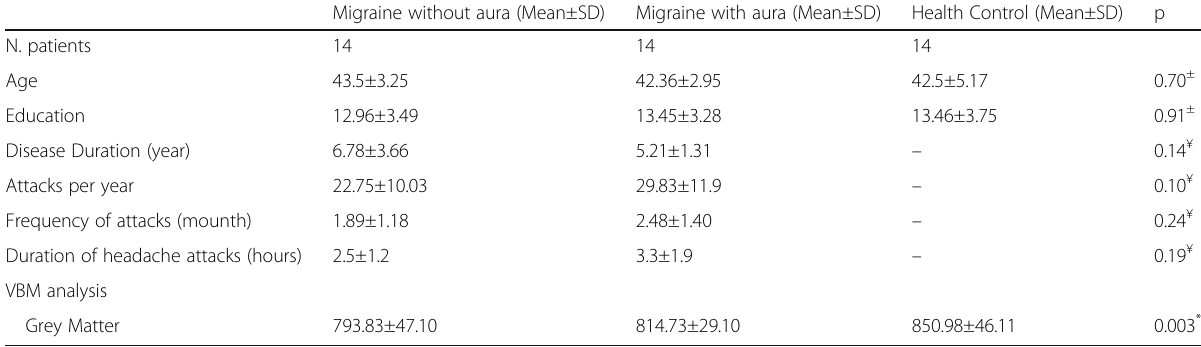
Table 1 Socio-demographic and clinical characteristics of three groups (% frequency) Migraine without aura (Mean±SD) Migraine with aura